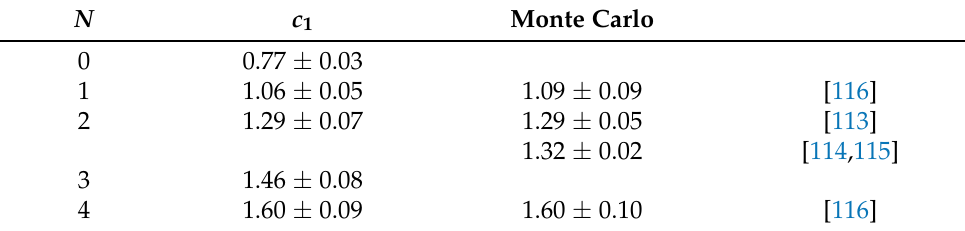
Table 2. Critical temperature shift obtained using self-similar factor approximants, as compared with Monte Carlo